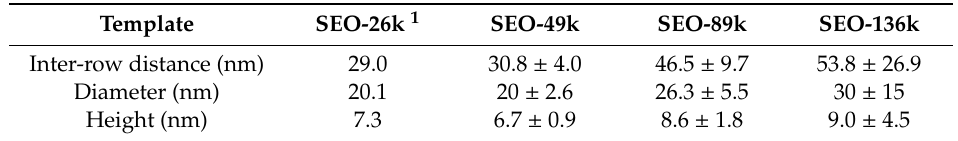
Table 2. Structural parameters deduced from the fit of the experimental GISAXS results, where inter-row distance is the center-to-center distance between two rows of